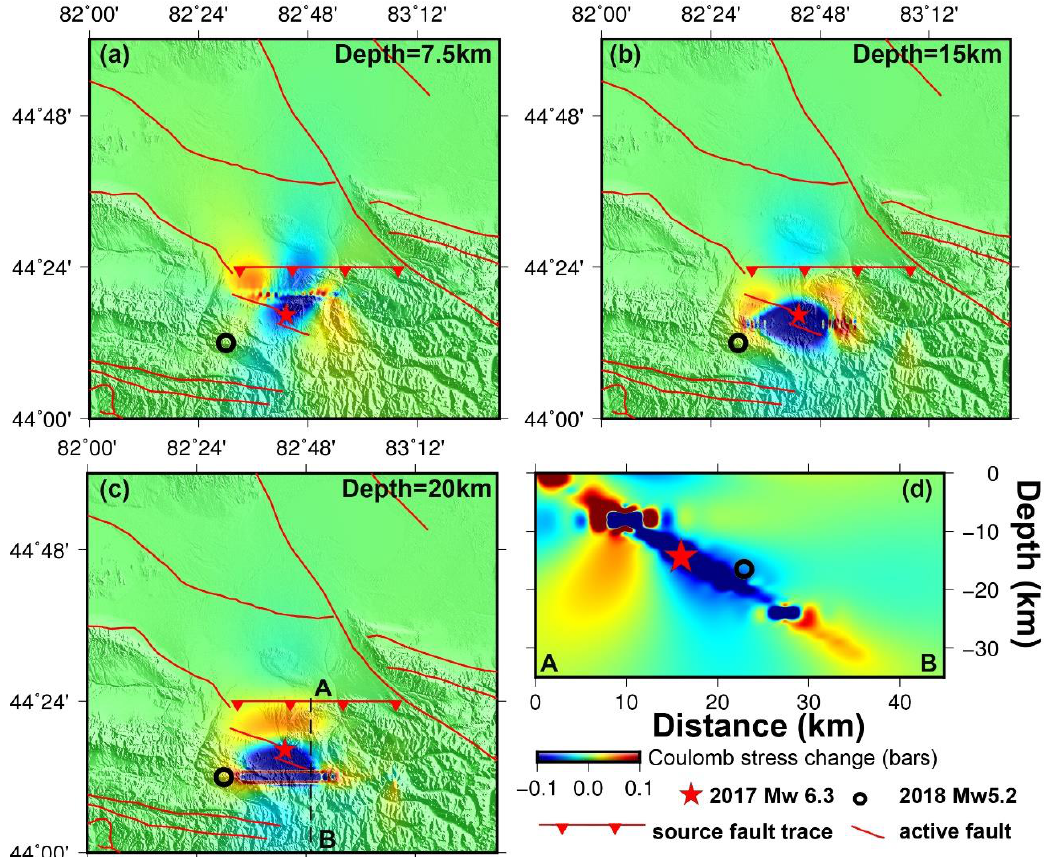
Figure 10. Coulomb stress change caused by the 2017 Mw 6.3 Jinghe earthquake based on the optimal Interferometric Synthetic Aperture Radar (InSAR) south-dipping distributed slip model. ( a – c ) Distribution of Coulomb stress change at a depth of 7.5, 15, and 20 km, respectively; ( b ) cross-section of Coulomb stress change along profile A – B. The red star denotes the epicenter of the 2017 Mw 6.3 Jinghe earthquake derived by InSAR, and the black circle denotes the epicenter of the 2018 Mw 5.2 event [23].